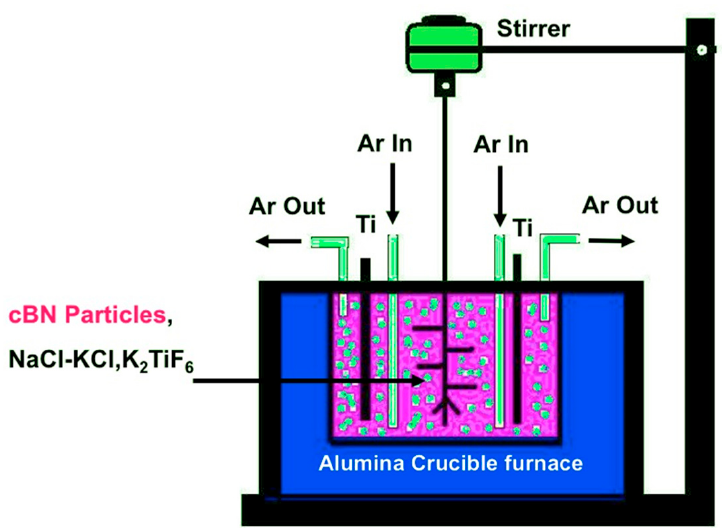
Figure 1. Experimental setup of the Ti ‐ metallization process of the cBN particles by molten salt reaction at 900 °C.